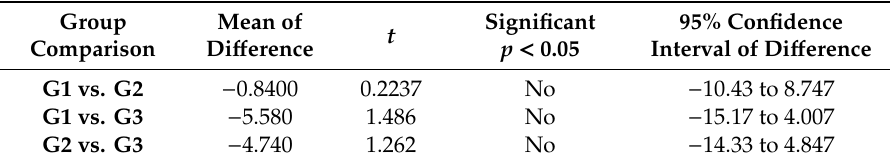
Figure 9. Graph showed the value distribuition in each group. Table 3. Bonferroni’s multiple comparison test to compare the BIC% values between the groups. Group